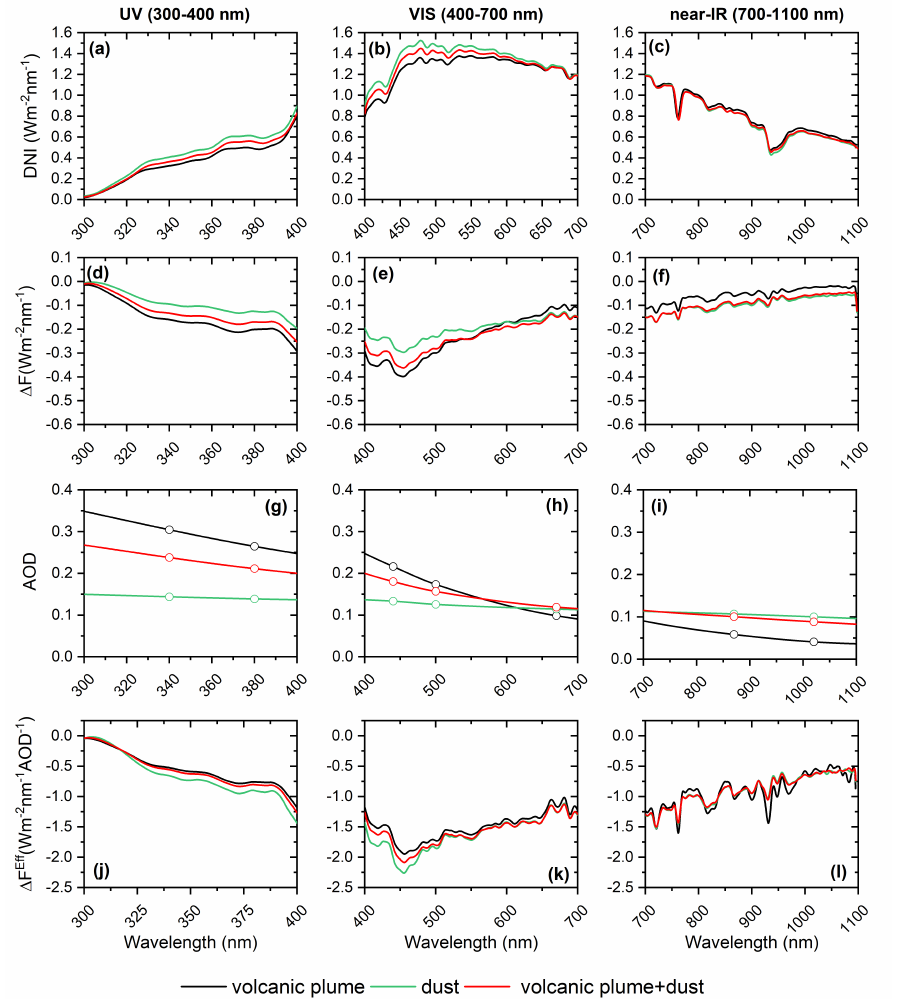
Figure 7. Spectral direct normal irradiance (DNI, Wm − 2 nm − 1 ) ( a – c ), aerosol direct radiative forcing ( ∆ F , Wm − 2 nm − 1 ) ( d – f ), and aerosol direct radiative forcing efficiency ( ∆ F Ef f , Wm − 2 nm − 1 AOD − 1 ) ( j – l ), considering the AOD at each measured wavelength of the EKO ( g – i ), for the UV (300–400 nm), VIS (400–700 nm), and near-IR (700–1100 nm) spectral ranges at an SZA of 30 ◦ and for the three case studies at the IZO: volcanic plume (black), dust (green), and volcanic plume + dust (red). The circles in ( g – i ) represent the AOD performed by